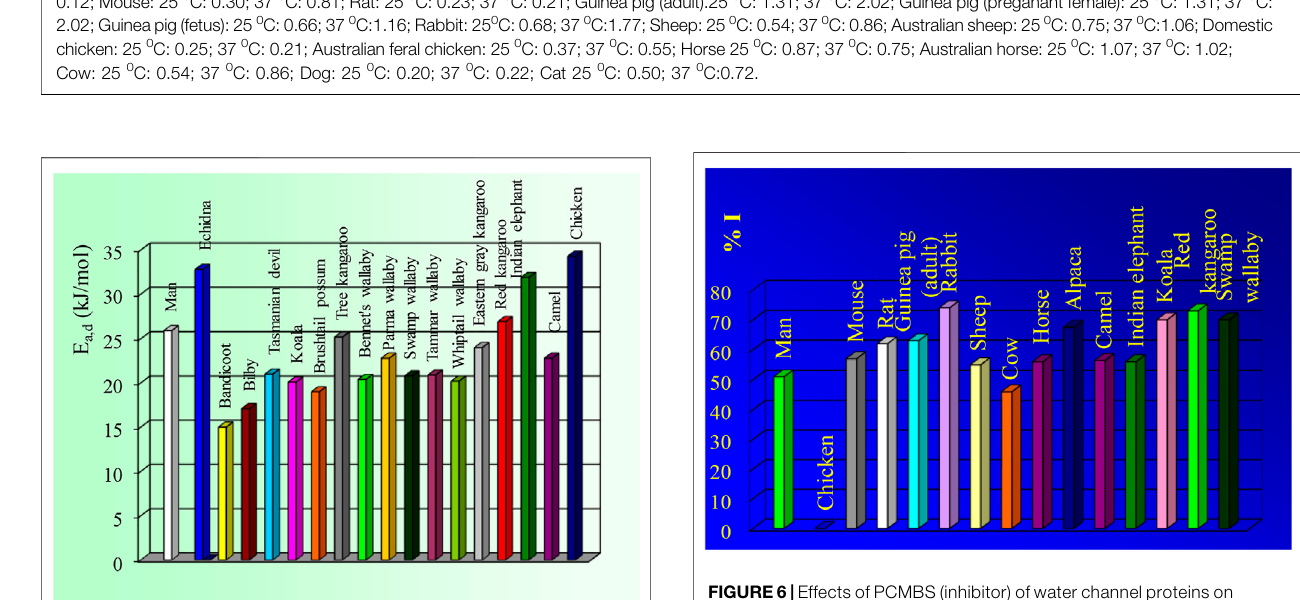
FIGURE6| Effects of PCMBS (inhibitor) of water channel proteins on water diffusion through the RBC membrane of man and several animal species. The highest value of inhibition is presented for each species. The original results were published previously (Benga et al., 1992b; Benga and Borza, 1995; Benga et al., 1999; Benga et al., 2000a; Benga et al., 2003; Benga et al., 2010a; Benga et al., 2010b; Benga, 2013; Benga et al.,